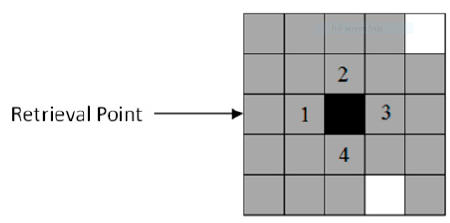
Figure 3. Importance of the optimal side of requested items.